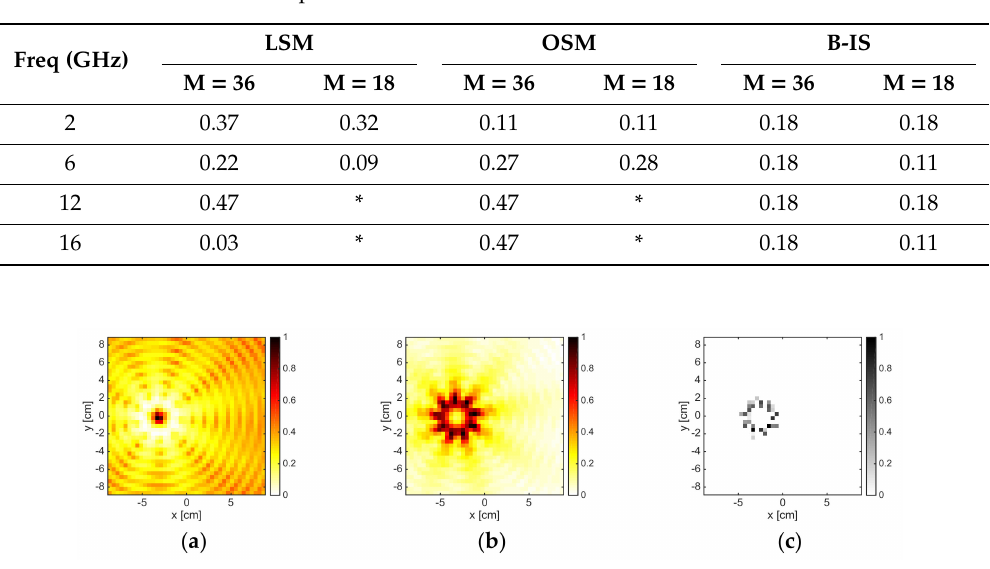
Table 3. Dimensional errors for the DielTM target. LSM and OSM indicators were binarized by selecting L = 0.8. The symbol * indicates the cases wherein the indicator maps were not reliable, and the dimensional error was not computed.